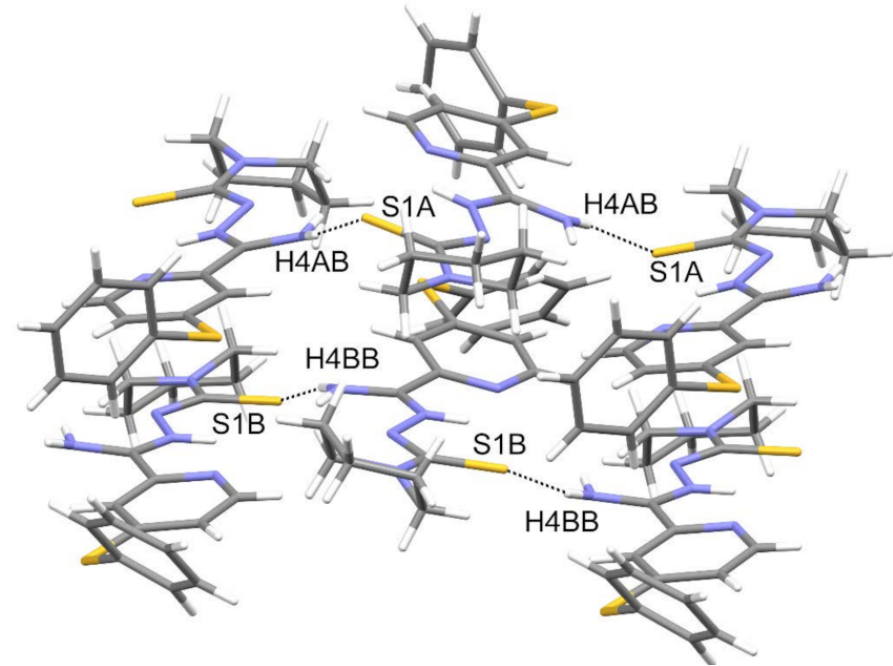
Figure 5. The intermolecular hydrogen bonds in compound 2 . In its crystal, the molecules of compound 3 form a chain via N4—HbB ··· S1 type hydrogen bonds (Figure 6, Table 5). Additionally, intramolecular hydrogen bonds are formed (N4—H4A ··· N2). The molecule fragment ( N ’-thioformylpicolinohydrazonamide) takes a flat form (r.m.s. deviation = 0.0847 Å).